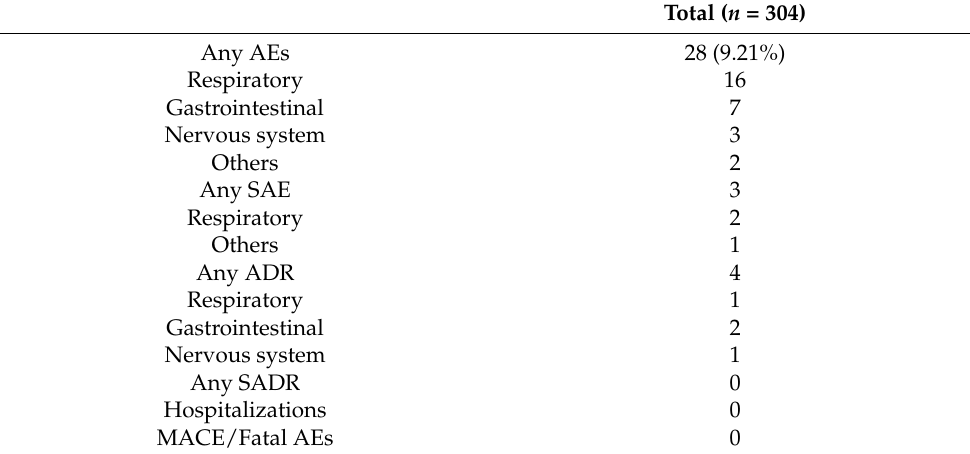
Table 3. Summary of reported adverse events